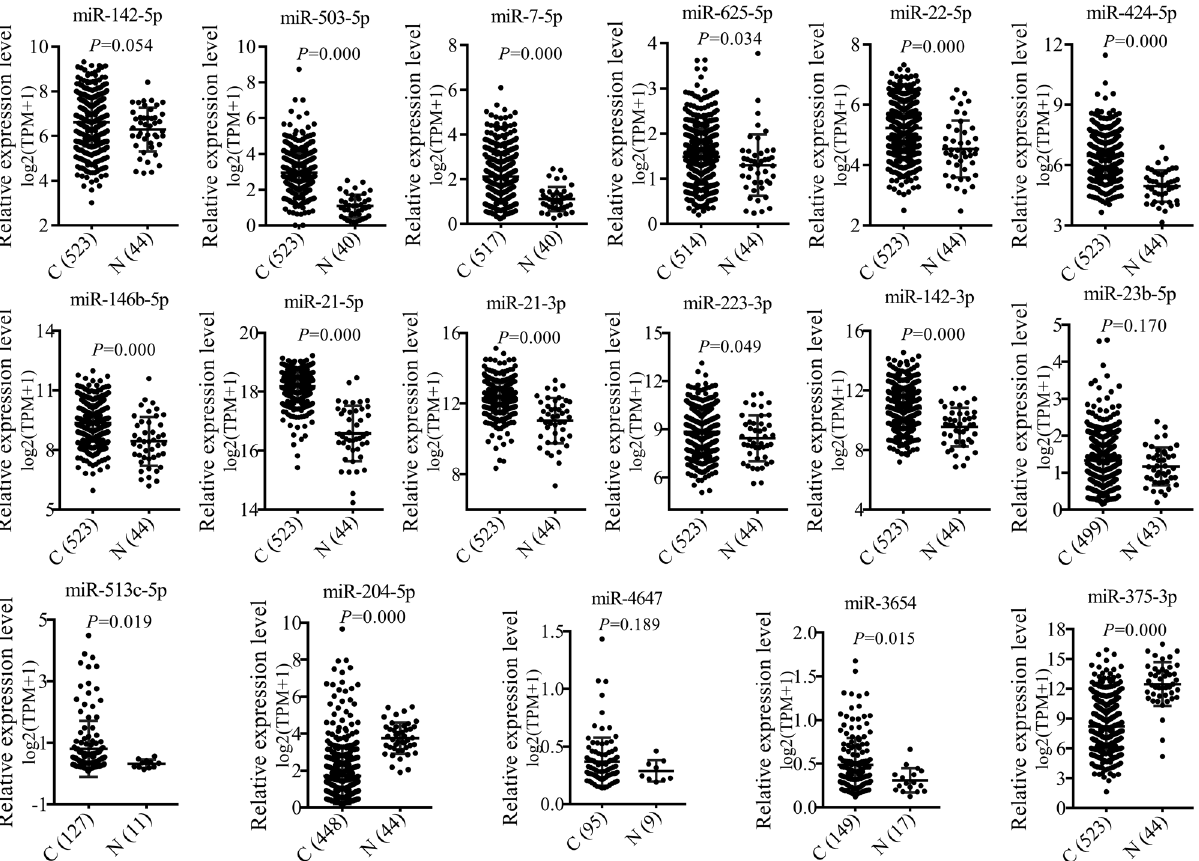
Figure 3: Expression levels of miRNAs in SCCHN based on TCGA database. X - axis represents the types of tissues, C, cancerous tissues, N, normal tissues. The numbers in parentheses represent the number of samples. Due to the absence of some miRNA expression values in expression pro fi le data, the sample sizes are unequal for di ff erent miRNAs. Y - axis represents the relative expression levels of miRNAs in SCCHN tissues. TPM, transcripts per million. A value of p < 0.05 means signi fi cant di ff